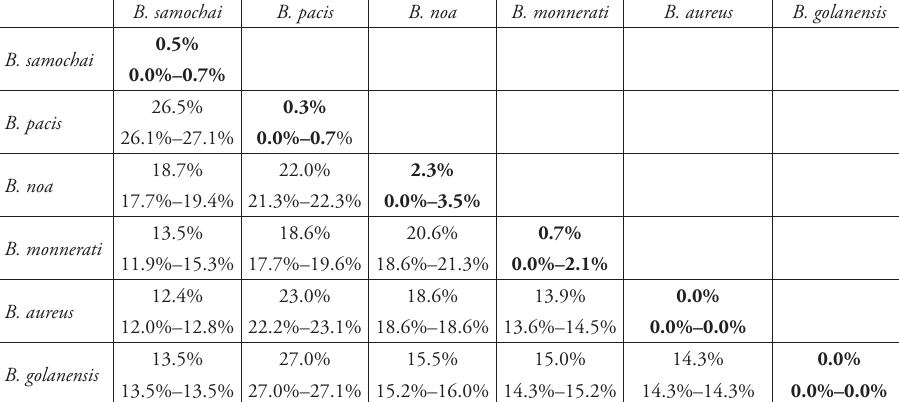
Table 1. Intraspecific (bold) and interspecific genetic distances among sequences of the mitochondrial COI gene of the six Israeli Baetis species (mean,